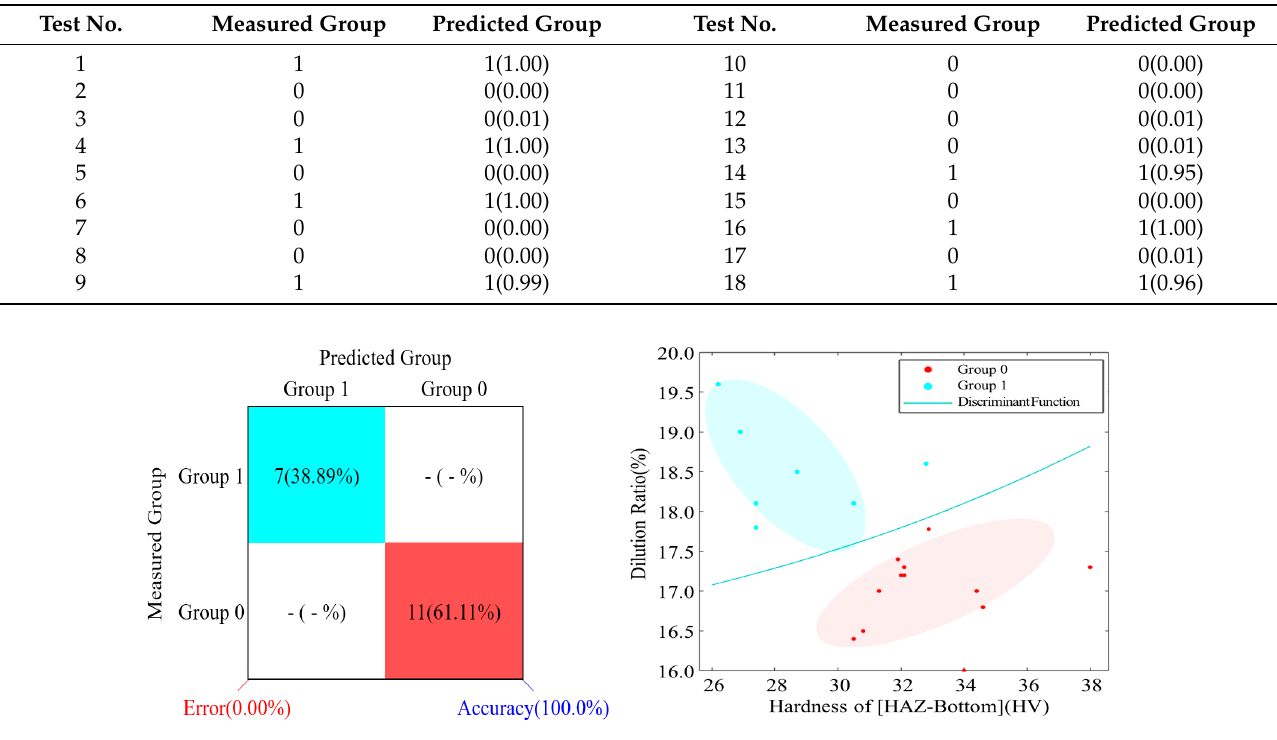
Table 10. Results of group discriminants for weld joint hardening according to SVM.